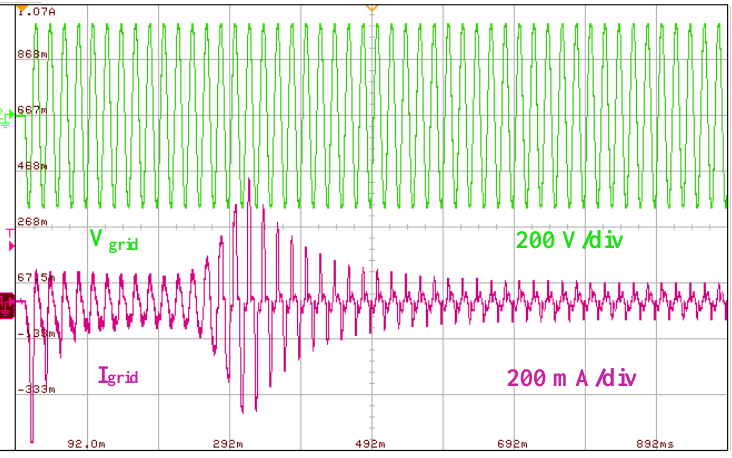
Figure 12. Grid voltage V grid (green) and grid current I grid (purple) during the start-up.